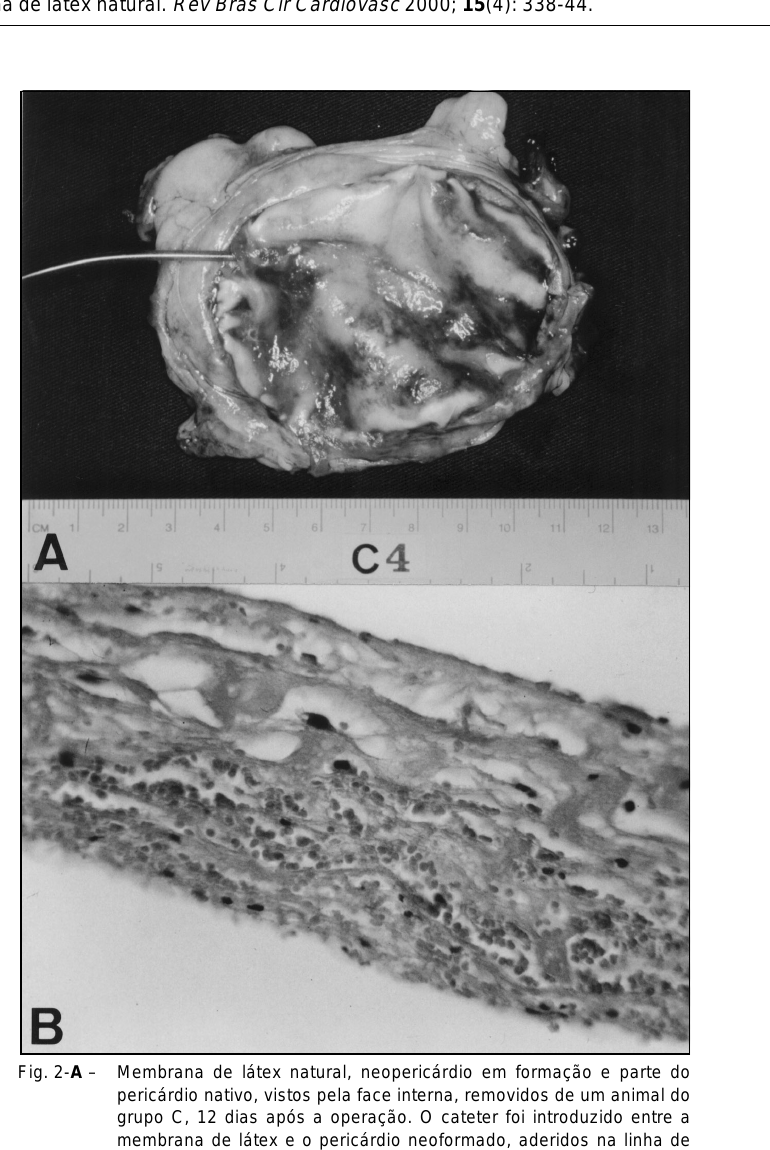
Fig. 2- A – Membrana de látex natural, neopericárdio em formação e parte do pericárdio nativo, vistos pela face interna, removidos de um animal do grupo C, 12 dias após a operação. O cateter foi introduzido entre a membrana de látex e o pericárdio neoformado, aderidos na linha de sutura, apenas. B – Fotomicrografia do neopericárdio em fase precoce de formação, vendo-se o material colagenizado e fibroblastos em meio à proliferação vascular. H-E x